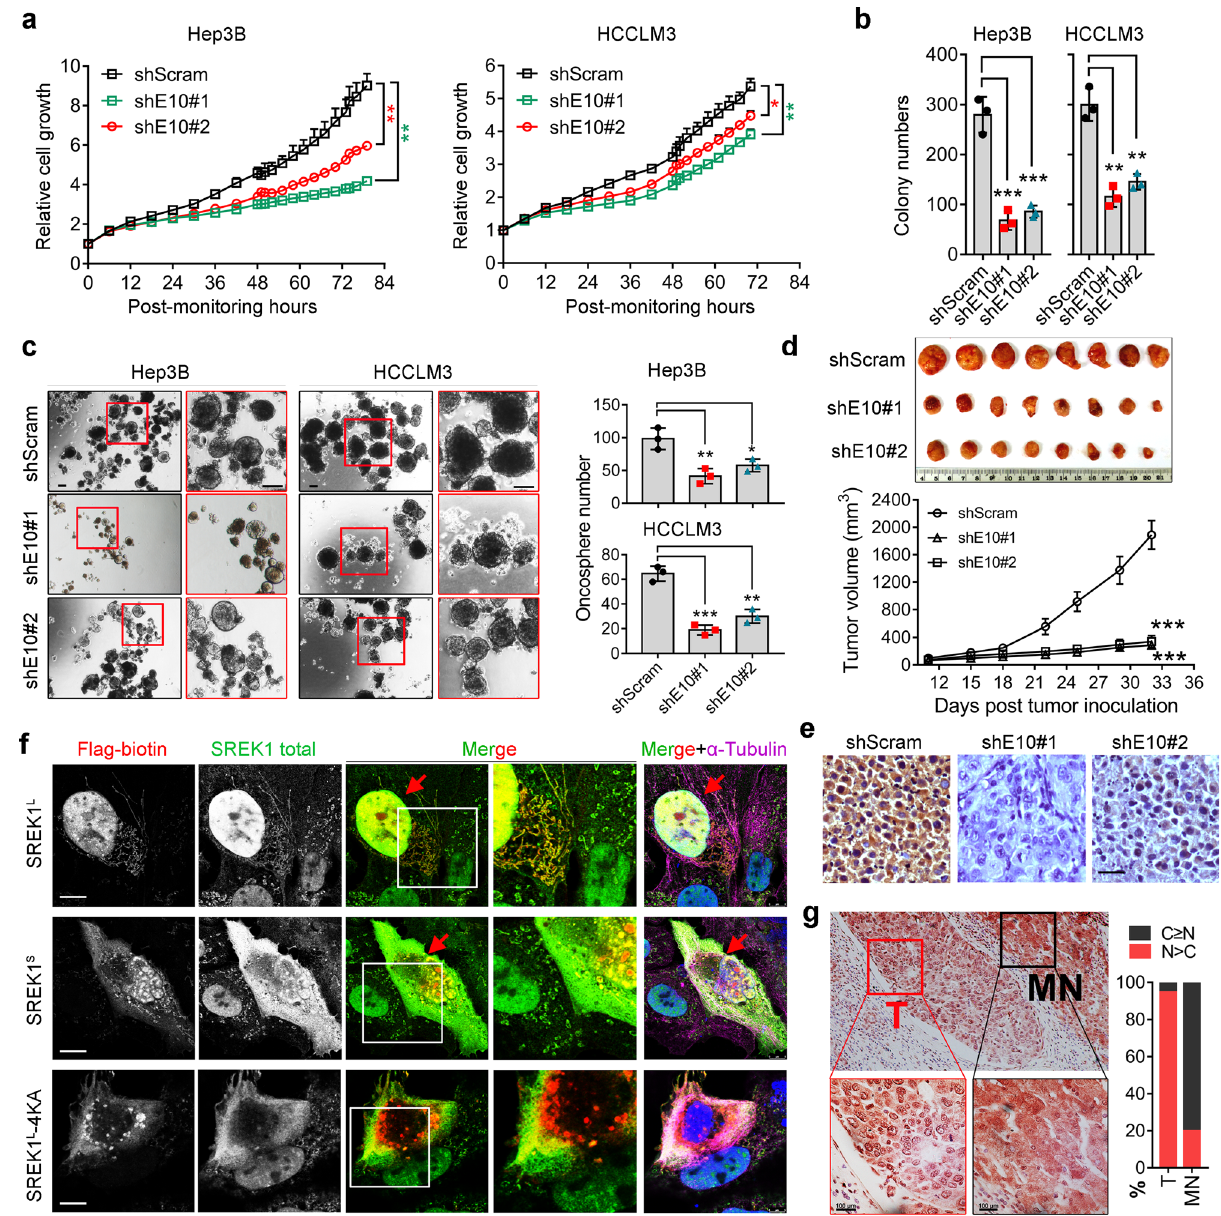
Fig. 2 SREK1 L is an oncogenic driver with nuclear localization in HCC. a Cell growth analysis ( n = 3), data are shown as the mean ± SEM. b Anchorage- independent soft agar colony formation assays ( n = 3), and c oncosphere assays ( n = 3) of cells in which scramble control or exon 10-speci fi c SREK1 was stably knocked down (scale bar = 200 μ m), data are shown as the mean ± SD. d Mouse tumorigenic assays of Hep3B cells with scramble control or exon 10-speci fi c SREK1 stably knocked down ( n = 8, data are shown as the mean ± SEM). e The immunohistochemical staining of the representative xenograft tumor tissues, scale bar = 100 μ m. f Confocal microscopy showing immuno fl uorescence staining for Flag-tagged SREK1 L and SREK1 S (shown in red) and their colocalization with endogenous SREK1 (shown in green), microtubules (shown in purple) and nuclei (stained with DAPI, shown in blue) in HCCLM3 cells. Scale bar = 5 μ m. g Representative immunohistochemical staining of HCC patient tissues for endogenous SREK1 (Scale bar = 100 μ m, left panel); T tumor tissues, MN matched normal tissues, C cytoplasm, N nucleus. The amount of SREK1 in the cytoplasm or nuclei of cells in tumor or matched normal tissues from HCC patients was quanti fi ed ( n = 10, right panel), C>N indicates more speci fi c SREK1 detected in the cytoplasm, N>C indicates more speci fi c SREK1 staining in the nucleus. Two-tailed, unpaired t test is used for statistical analysis of ( a , b , c , e ), * p < 0.05; ** p < 0.01; *** p < 0.001. Source data are provided as a Source Data fi SREK1 L has been detected with nuclear localization in HCC HCCLM3 cells. Antibodies against Flag, total SREK1 (detecting tissues (Fig. 1h), and a putative consensus sequence of the both forms of SREK1) and α -Tubulin were used to stain and bipartite nuclear localization signal (NLS) – KKDKK 26 has been assess their localization in HCC cells (Fig. 2f). Confocal identi fi ed in EK domain (Supplementary Fig. 2o). We therefore microscopy con fi rmed that endogenous SREK1 localized mainly speculate whether the exon 10 inclusion alters the subcellular to the nucleus (Fig. 2f). Flag-SREK1 L was mainly detected in the localization of SREK1 via selective expression of the EK domain. nucleus, while Flag-SREK1 S and an NLS mutant named Flag- SREK1 L -4KA generated by the mutation of all four Lysine (K) Flag-SREK1 L and Flag-SREK1 S constructs were transfected into